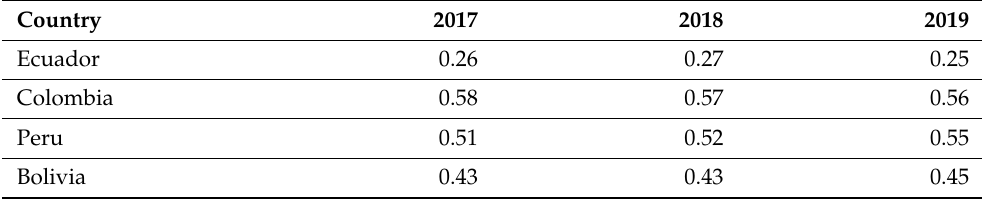
Table 5. The total scores in the energy security dimension in the Andean Community members. Country